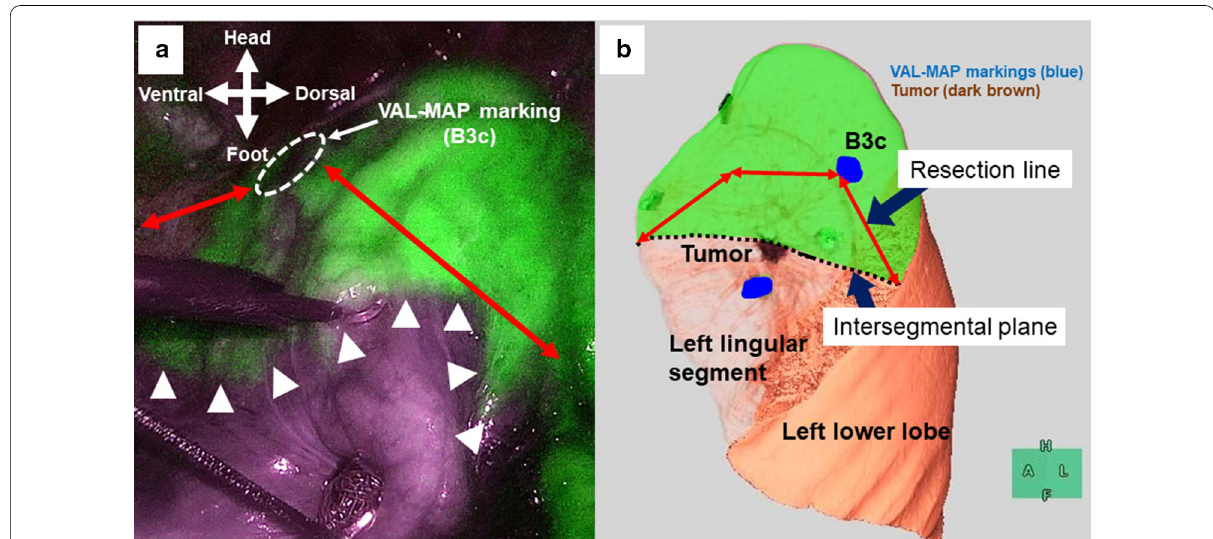
Fig. 3 a Near-infrared imaging shows the delineation of the intersegmental plane (arrowheads) between the left lingular segment and the left upper division segment, created by the systemic indocyanine green injection. The white circle surrounded by dotted lines suggests a VAL-MAP mark (B3c) and the red lines show the resection lines. b Three-dimensional image shows the intersegmental plane and the resection line. The blue color represents the VAL-MAP marking and the dark brown area is the tumor